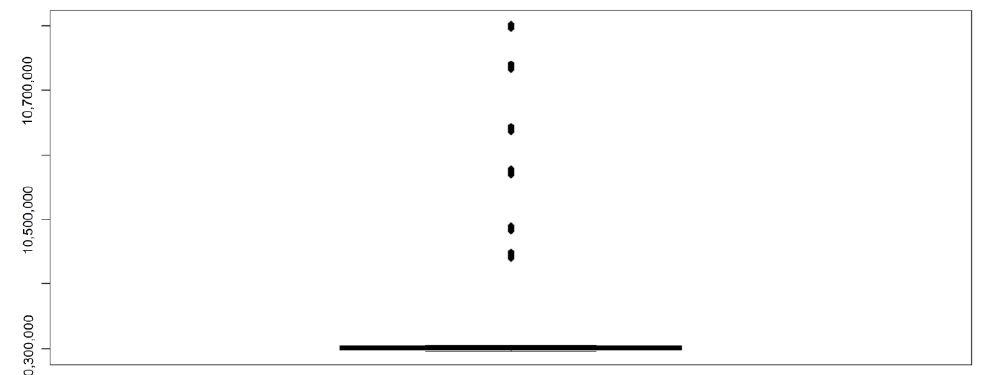
Figure 9. Box plot for pressure (Pa) globally (for all 26 time series). Pressure in (Pa): minimum 10,295,001, 1st quartile 10,297,708, median 10,300,330, mean 10,319,435, 3rd quartile 10,302,964, maximum 10,803,336. Figure 8. Box plot for humidity (%) globally (for all 26 time series). Humidity in (%): minimum 15.03, 1st quartile 18.86, median 20.04, mean 20.12, 3rd quartile 21.26, maximum 25.98.